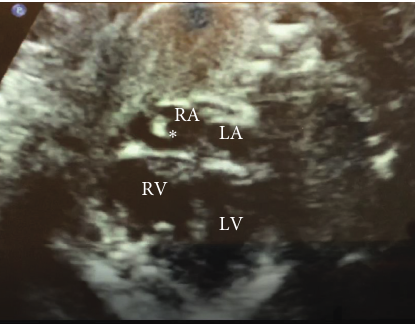
Figure 1: A 4-chamber fetal ECHO showing a 3.4 × 4.6mm echogenic structure ( ∗ ) in right atrium (RA) with consistency similar to the adjacent atrial tissue suggestive of crista terminalis.